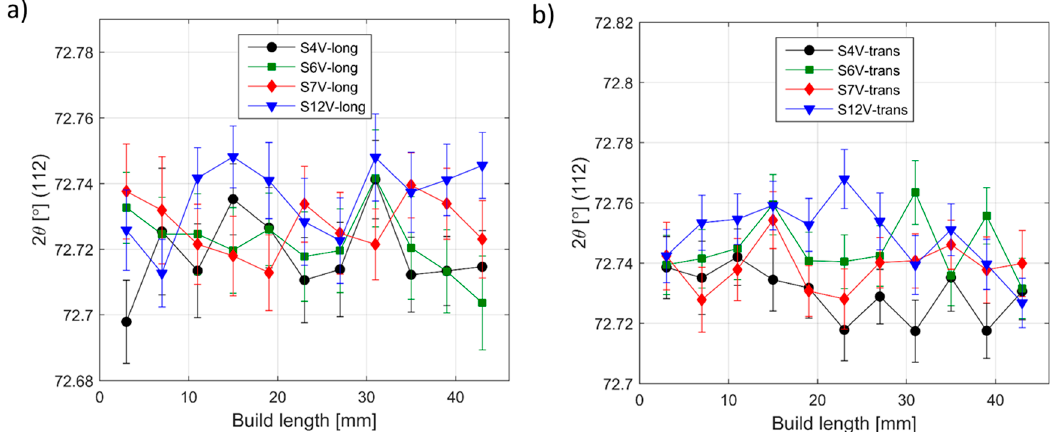
Figure 12. Variation of Ti(112) peak position with respect to build height by neutron diffraction. ( a ) Longitudinal direction, ( b ) transverse direction. It can be seen that variations are within the error bars.